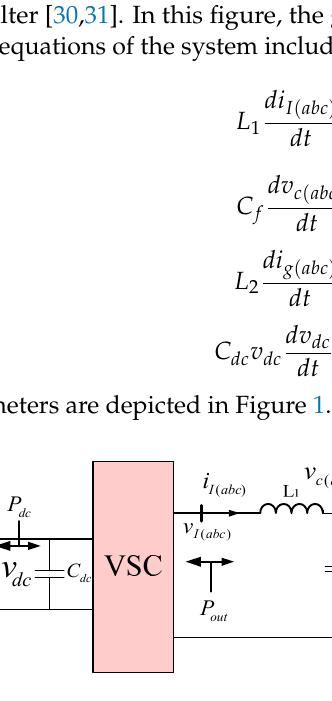
Figure 1. Single line diagram of a three-phase grid-connected VSC with LCL filter.